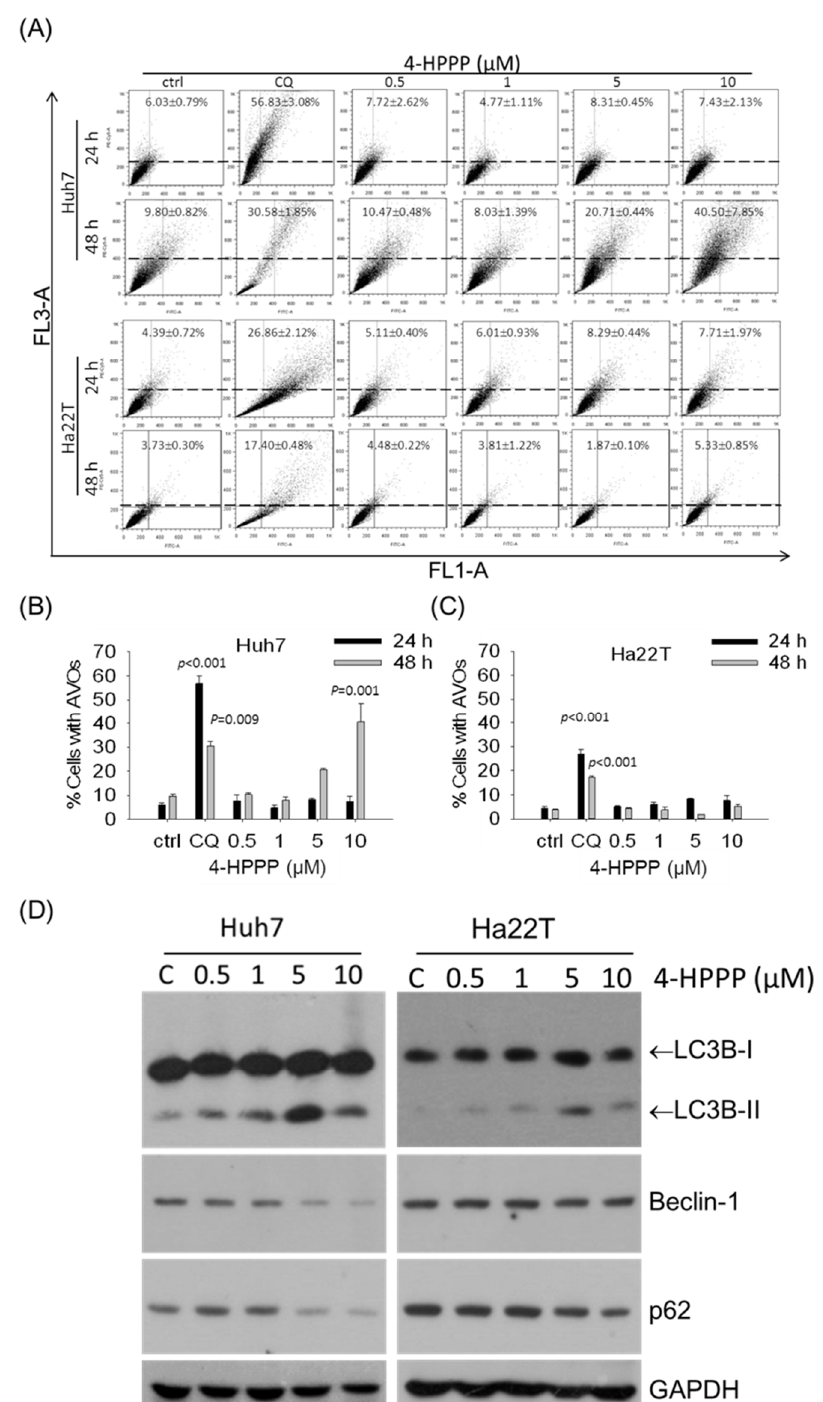
Figure 7. Autophagy assessment in 4-HPPP-treated HCC cells. ( A ) Huh7 and Ha22T cells were treated with 4-HPPP for 24 and 48 h respectively, and then subject to the autophagy assessment of flow cytometry-based AO staining. The formation of acidic vesicular organelles (AVOs) analyzed using a flow cytometry. ( B , C ) The quantitative analysis of AVOs of ( A ). 100 μ M of chloroquine (CQ) as a positive control. ( D ) The western blot assay showed the expression changes of autophagy-associated protein Beclin-1, p62, LC3B-I and its cleaved form LC3B-II following treatment with indicated concentrations of 4-HPPP for 48 h. GAPDH was used as an internal control for ensuring equal loading. 2.7. 4-HPPP Induces the Activation of γ H2AX and Down-Regulates the Pro-Survival Pathways